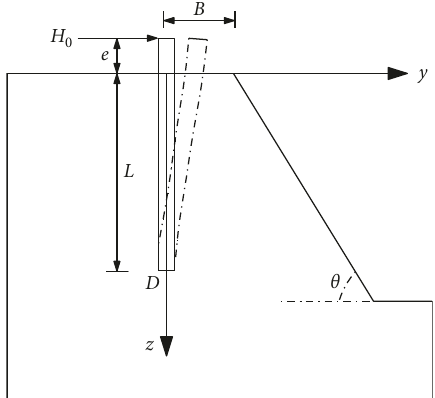
Figure 2: Analysis model